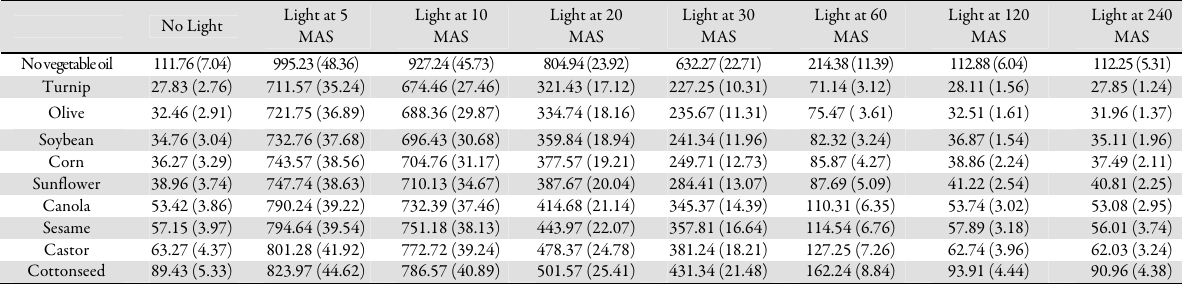
Tab. 1. ED 50 dose (g ai ha -1 ) of sethoxydim (alone and in a mixture with vegetable oils), affected by different light treatments